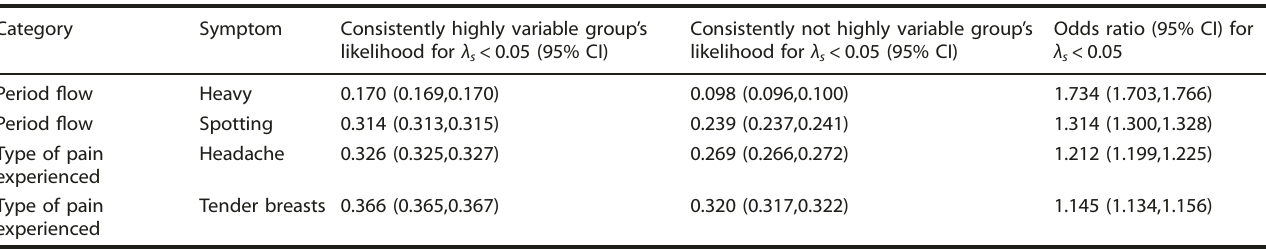
Table 5. Pain and period tracking odds ratios for low extreme end of the proportion range.